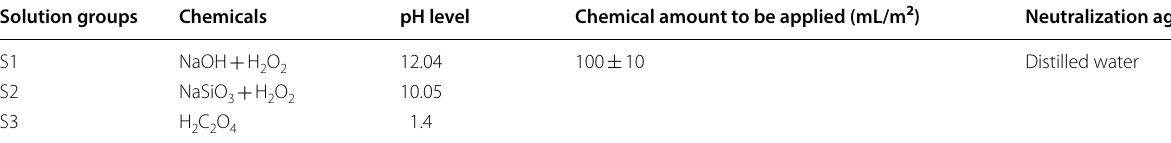
Table 1 Solution groups used in bleaching process on the surfaces of wood Solution